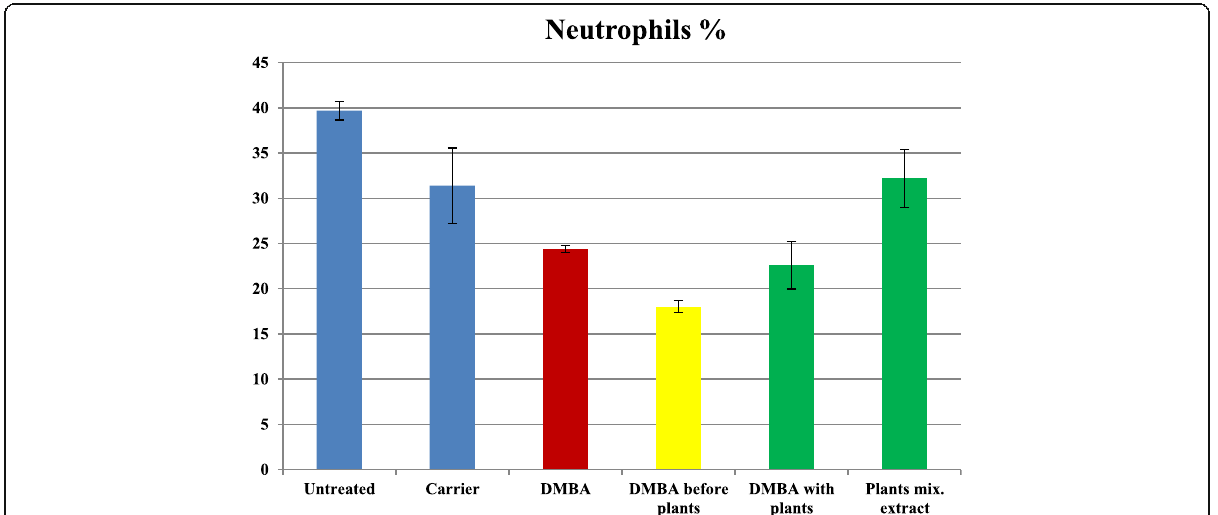
Fig. 4 Neutrophil percentage in the different rat groups. Standard errors are indicated on the bars and the significance levels are shown in